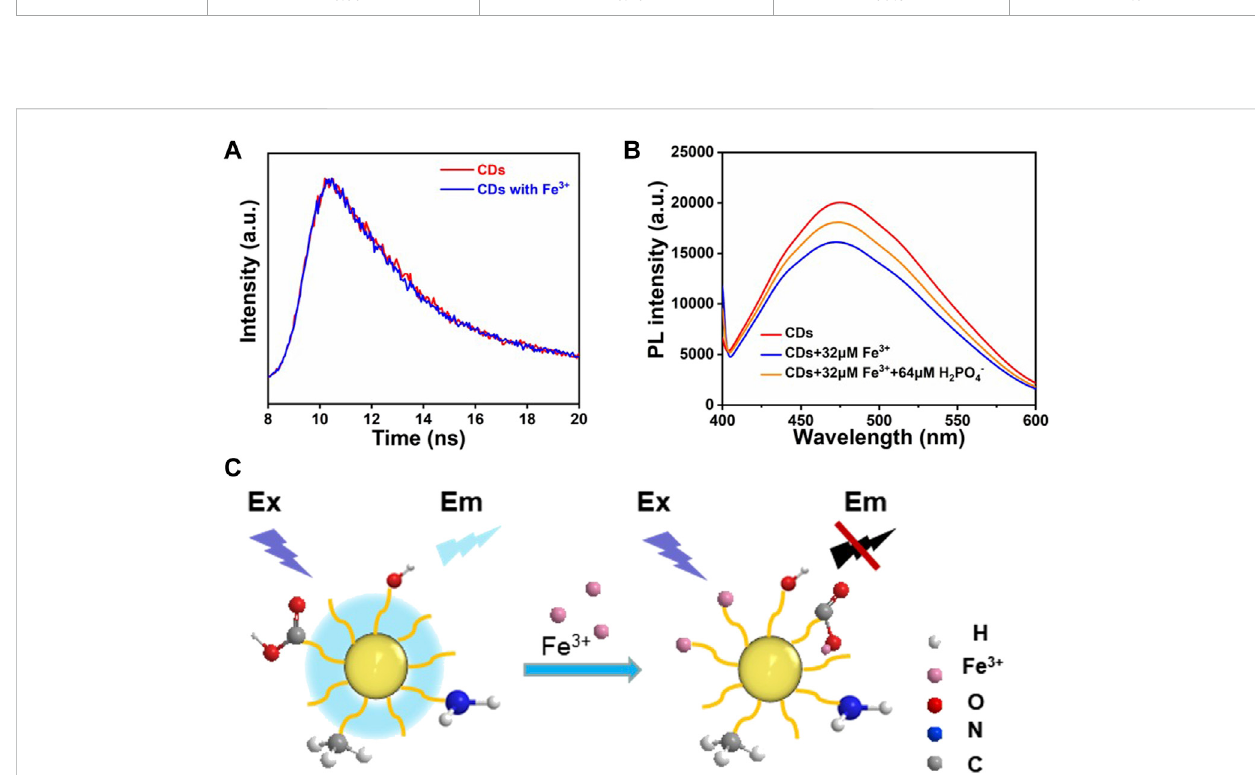
FIGURE 6 (A) The fl uorescencedecaycurvesoftheCDsandCDswithFe 3+ . (B) Comparisonof fl uorescenceintensityaftertheadditionofFe 3+ ionsandH 2 PO 4 − ions to CDs solution. (C) Fluorescence quenching mechanism of